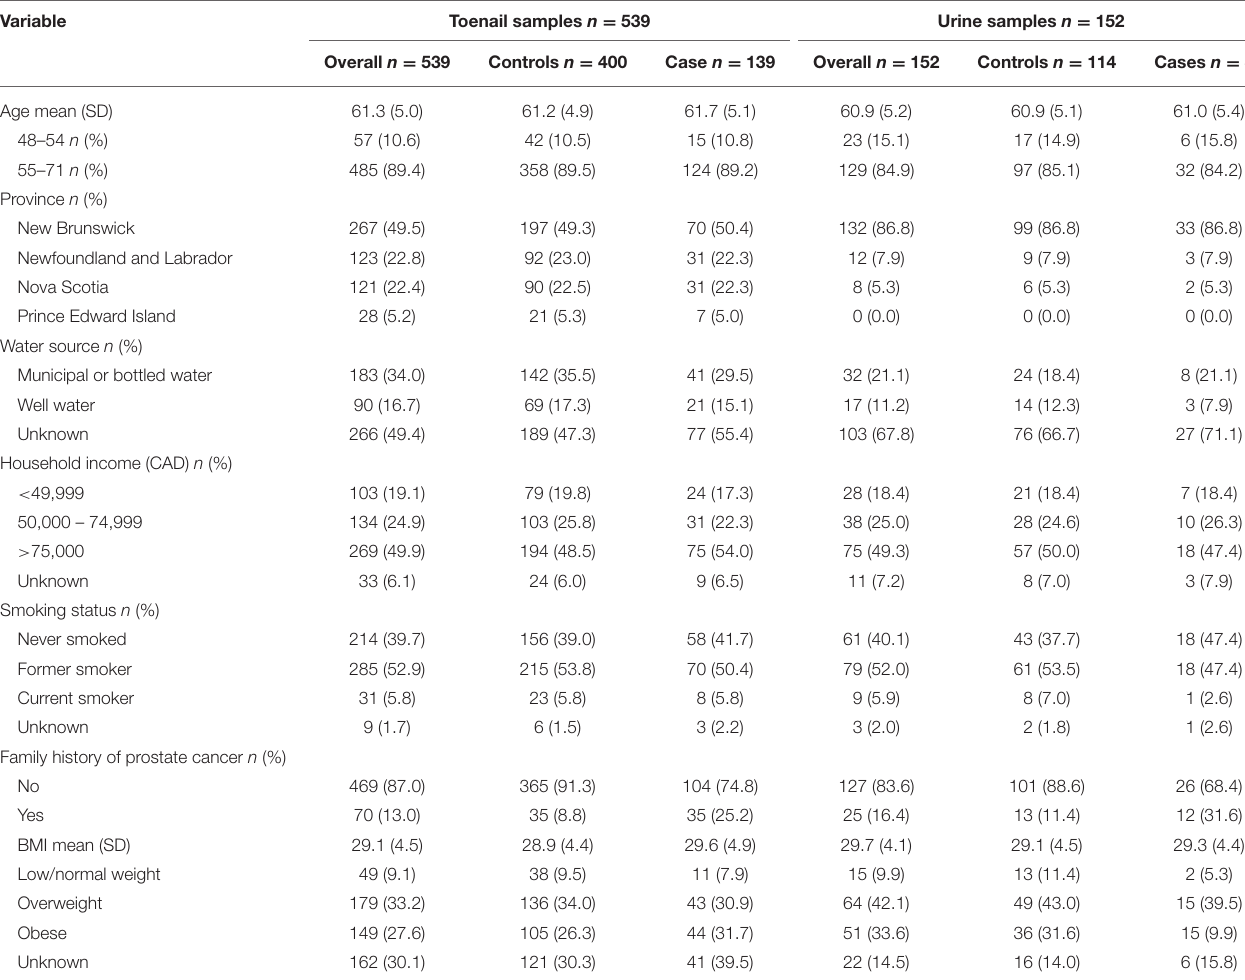
TABLE 1 | Participant characteristics of prostate cancer cases and controls from toenail ( n = 539) and urine ( n = 152) sample groups, sourced from the Atlantic PATH cohort study (2009-2015).